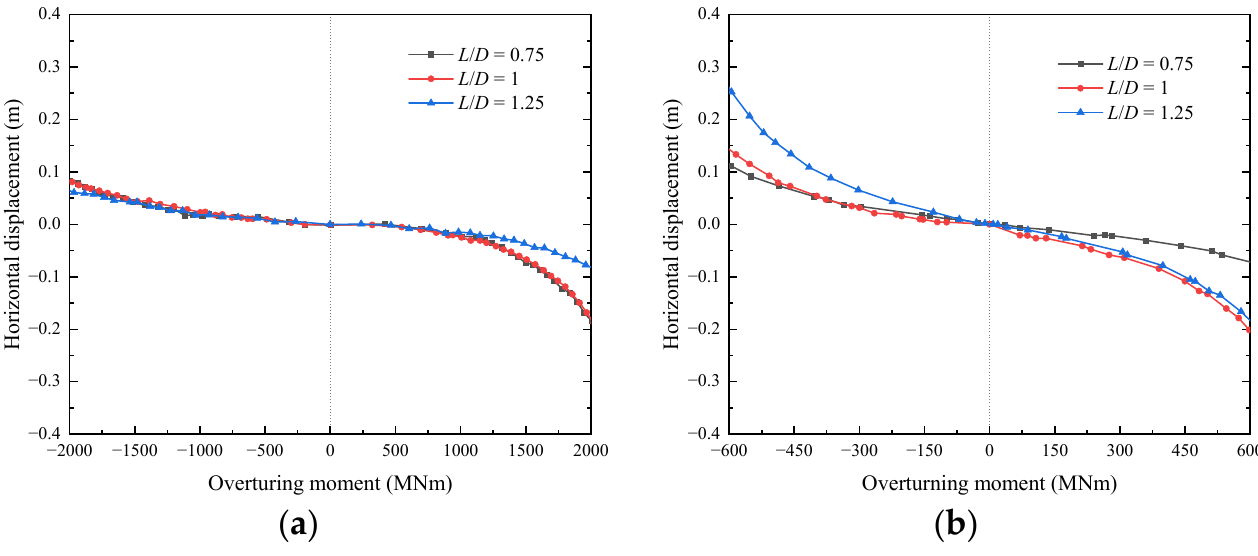
Figure 16. Horizontal movement response of tripod bucket foundation: ( a ) sand, ( b ) soft clay.